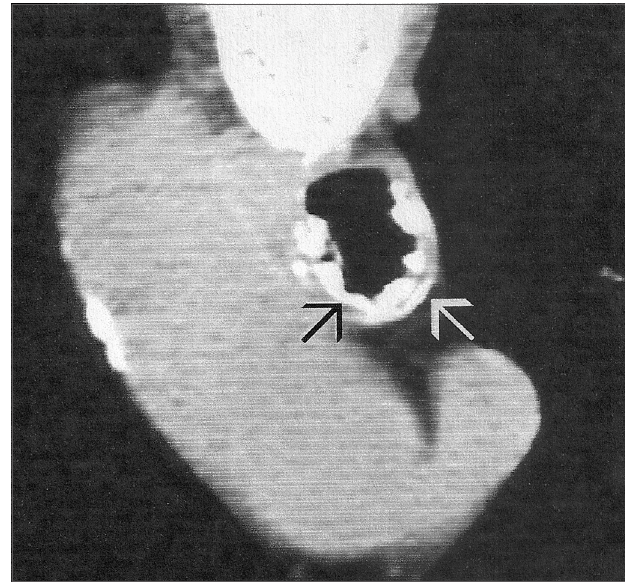
Figura 2. Fibrolaringotraqueobroncoscopia: visualização da carina com lesões nodulares, sem comprometimento da parede posterior da traqueia.